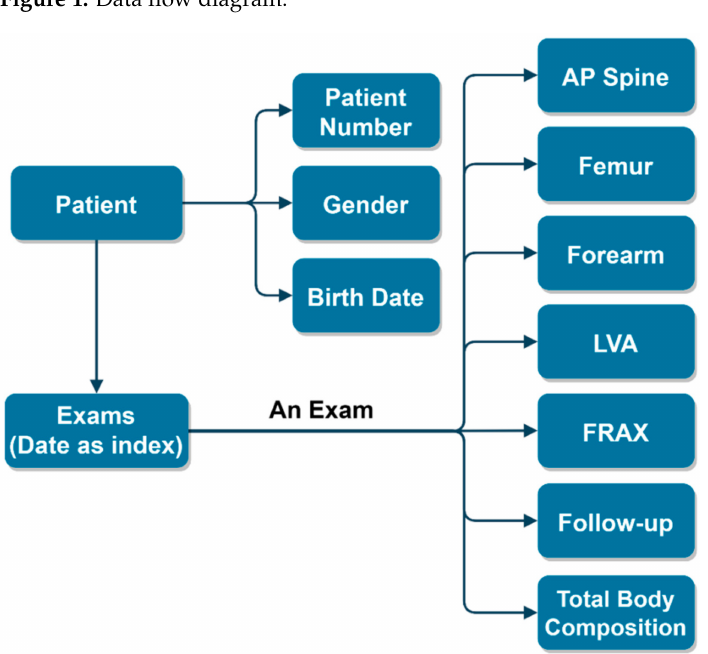
Figure 2. Data structure of the Patient object in